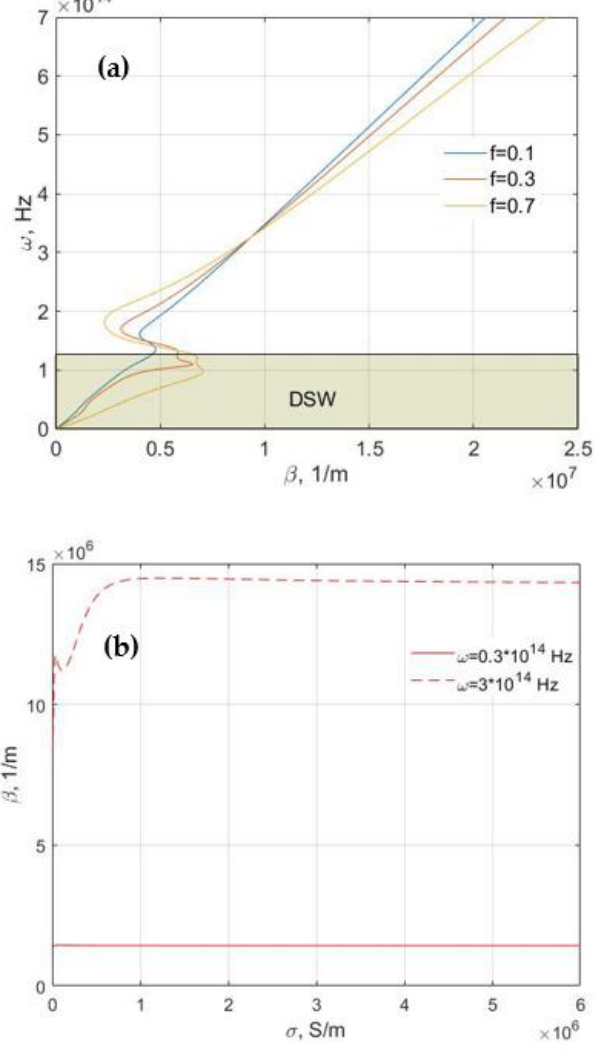
Figure 5. Solution of the dispersion equation versus frequency ( a ) and versus conductivity ( b ). ε n = 2.25, ε d = 11.8. Herein ITO inclusions are employed in nanocomposite and hypercrystal, f = 0.3 in ( b